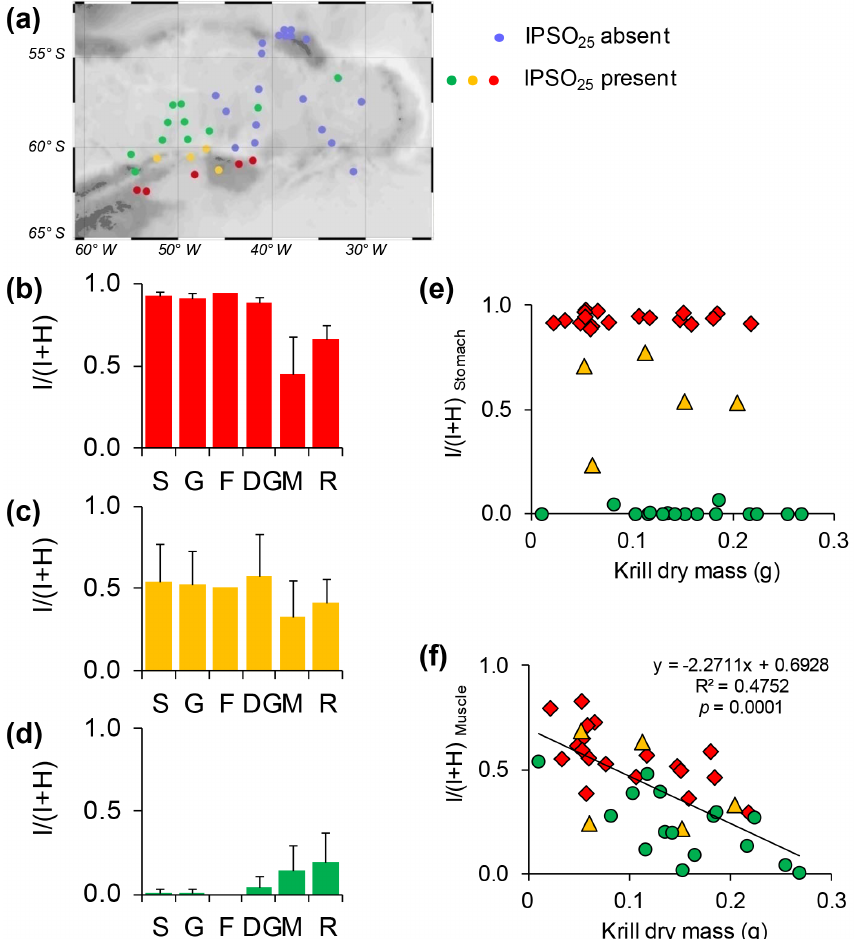
Figure 7. E. superba : multiple scenarios of krill feeding history on ice diatoms. (a) Location of stations where IPSO 25 was present in krill (red – Scenario 1; amber – Scenario 2; green – Scenario 3) or absent (purple). (b) Scenario 1: Krill are mainly feeding on ice diatoms. I / (I + H) ratios are high (>0.9) in stomach (S), gut (G), faecal pellets (F) and digestive gland (DG), but lower (0.4-0.7) in muscles (M) and rest of the body (R). (c) Scenario 2: Krill are feeding on a mixture of ice diatoms and open water diatoms. I / (I + H) ratios are moderate ( ∼ 0.5) in stomach, gut, faecal pellets and digestive gland, but lower (0.3–0.4) in muscles and rest of the body. (d) Scenario 3: Krill are feeding on open water diatoms, but fed on ice diatoms in the past. I / (I + H) ratios are very low (<0.1) in stomach, gut and digestive gland, but higher (0.1–0.2) in muscles and rest of the body. (e, f) The effect of krill body size on their feeding on ice diatoms. I / (I + H) ratios are presented separately for krill stomach content and muscle. The regression line indicates the overall negative relationship between I / (I + H) Muscle and krill body weight. Colour of symbols in accordance with panels (b–d) : red indicates krill that fed currently on ice diatoms; yellow indicates krill that fed currently on a mixture of ice and open water diatoms; green indicates krill that fed currently on open water diatoms. Individuals ranged from 16 to 42mm in standard 3 body length [ L ] and from 0.01 to 0.27g in dry mass [ M ] ( M = 1 × 10 − 6 L 3 . 2452 , R 2 = 0 . 9707). Each symbol represents 3–15 pooled individuals of the same body